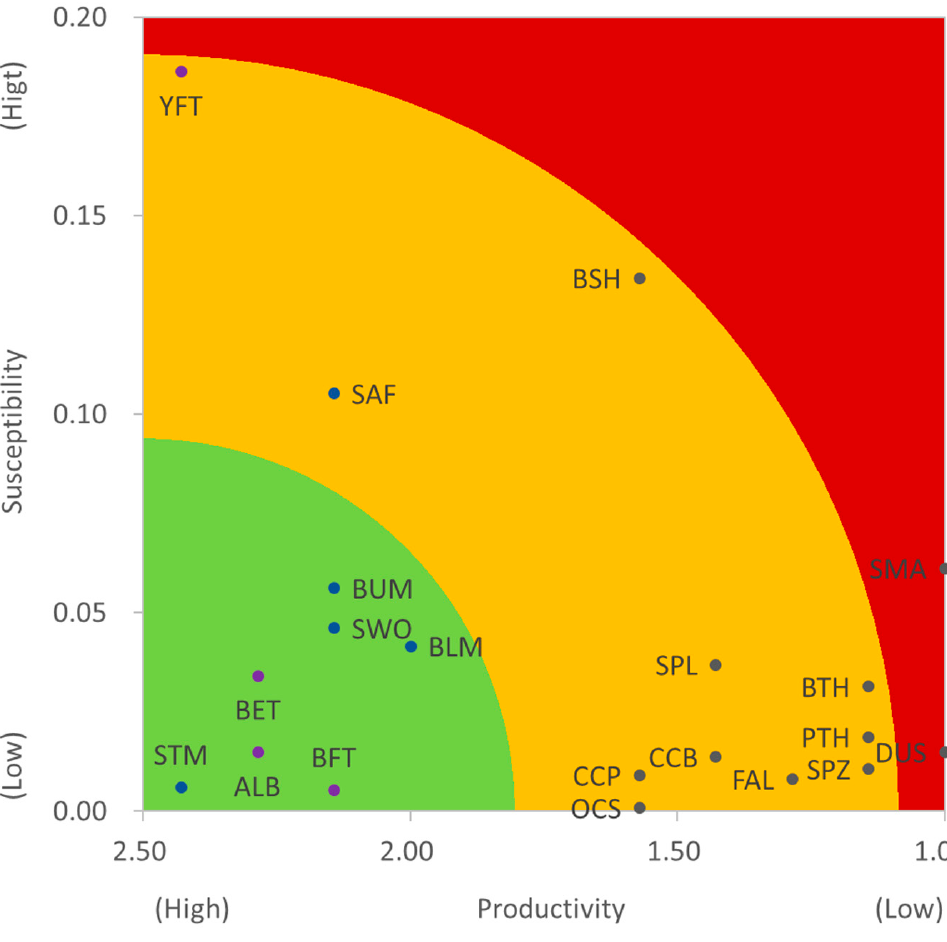
Figure 3. Productivity and susceptibility plot for the 20 pelagic fish species in the western North Pacific Ocean.